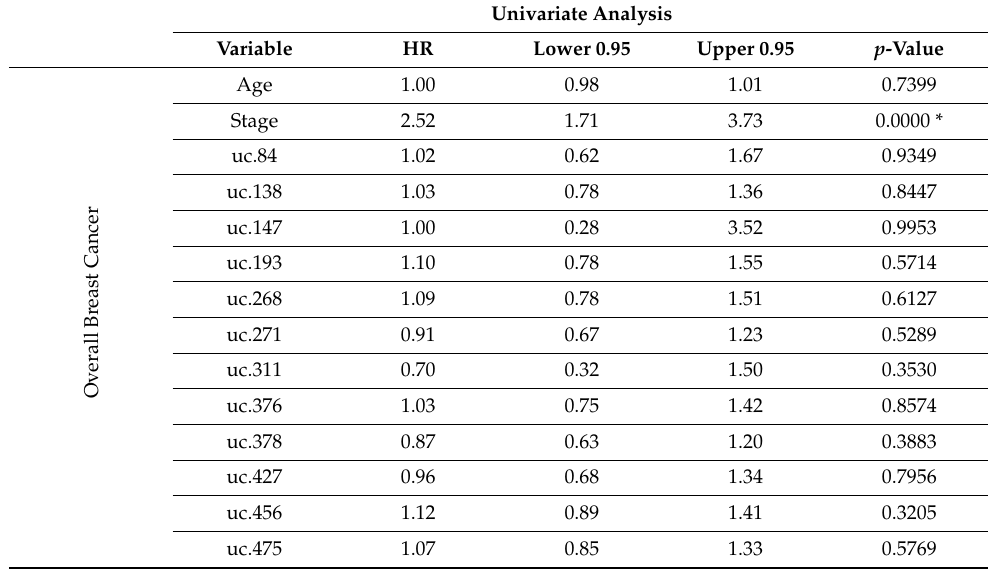
Table 4. Summary of univariate Cox regression analysis of al T-UCRs in patients’ Progression Free